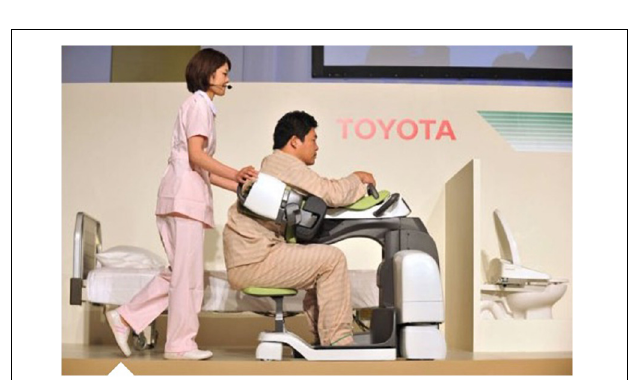
FIGURE 2 | Care Assist Robot (Source: Future of Occupation,